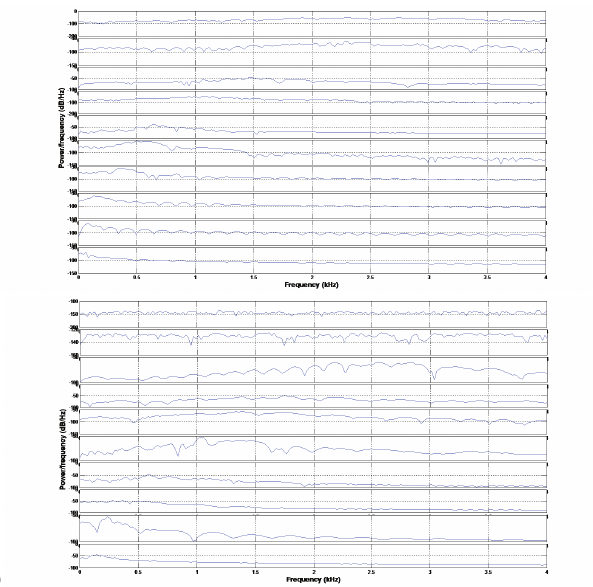
Figure 7. Power spectrum density of IMFs of response sig- nal of dry plate (a) and wet plate (b).